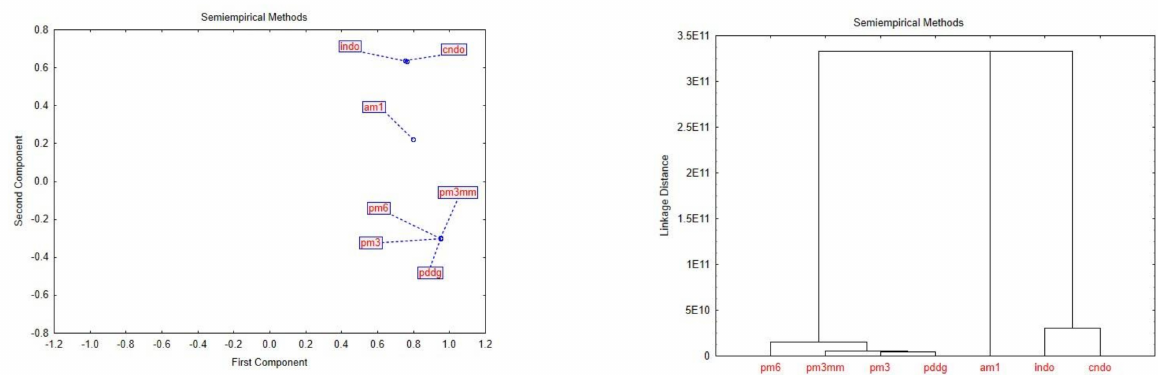
Figure 6. Score plot showing the distribution of the methods in the principal components p1 and p2 and cluster analysis.